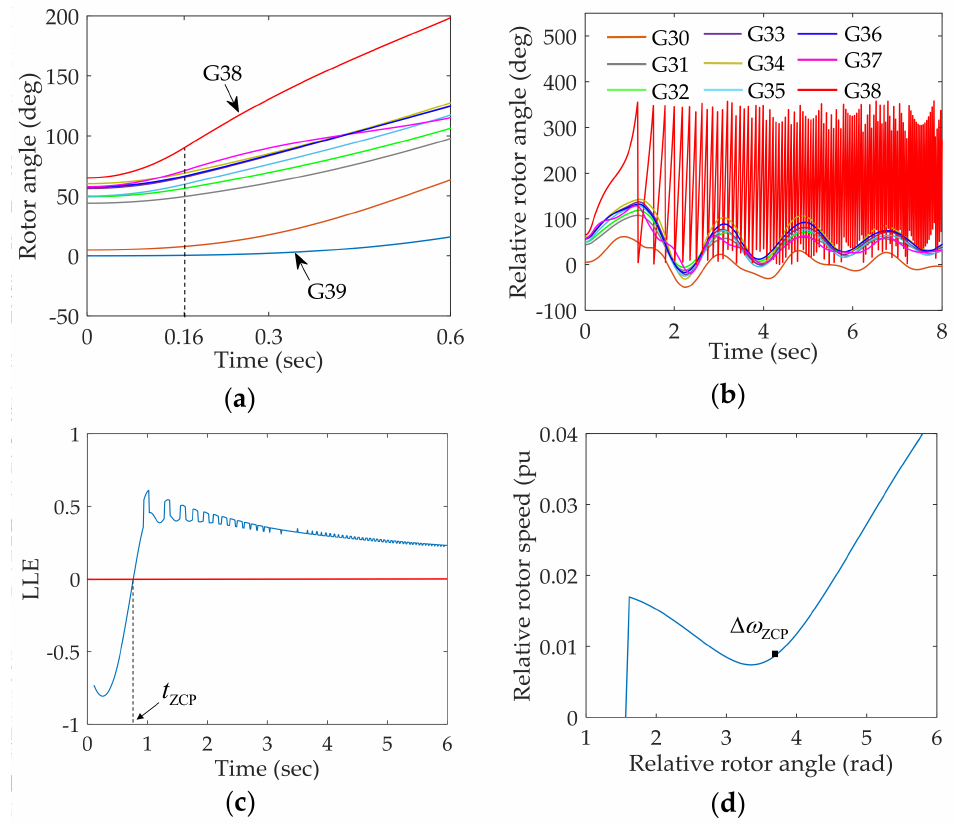
Figure 7. Simulation results for Case 2: ( a ) Rotor angle curves of generators after fault; ( b ) relative rotor angle curves after fault (G39 is the reference generator); ( c ) LLE–time curves; ( d ) phase-plane trajectories after clearing the